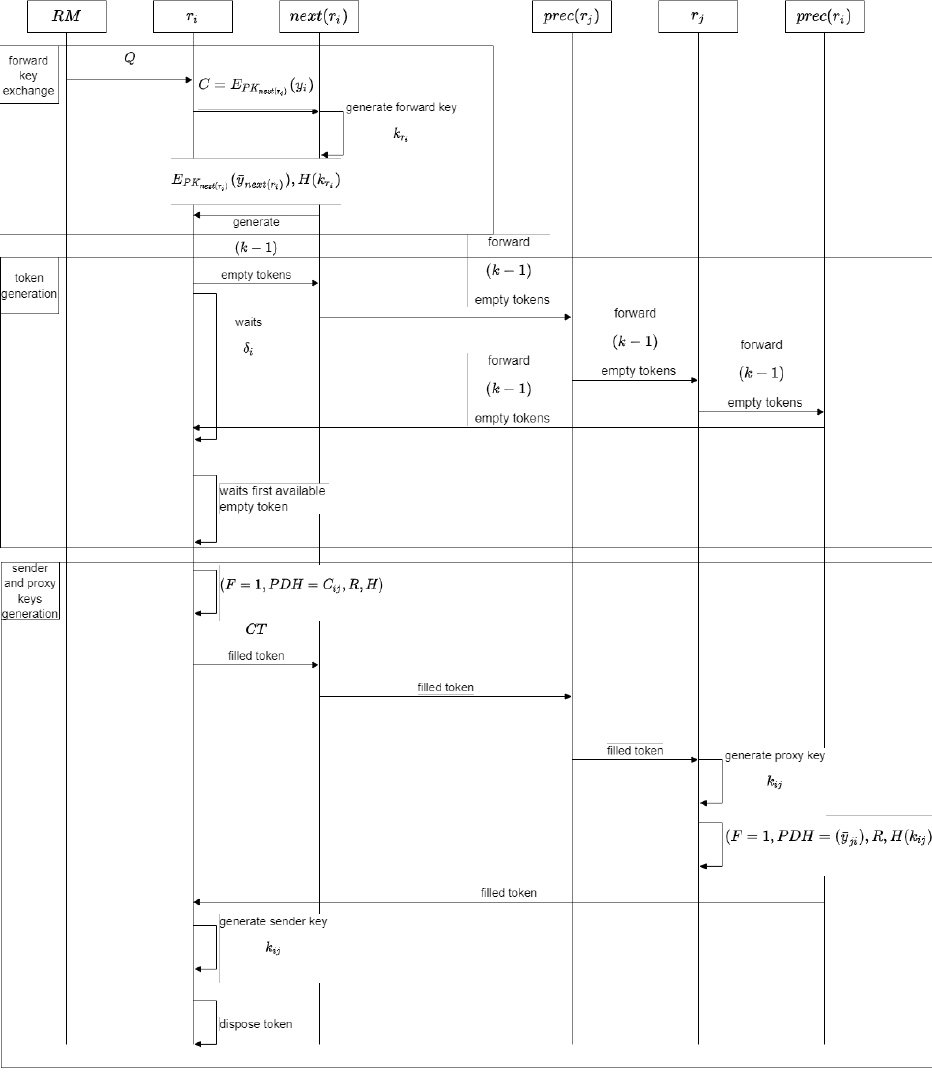
Figure 1. Set-up